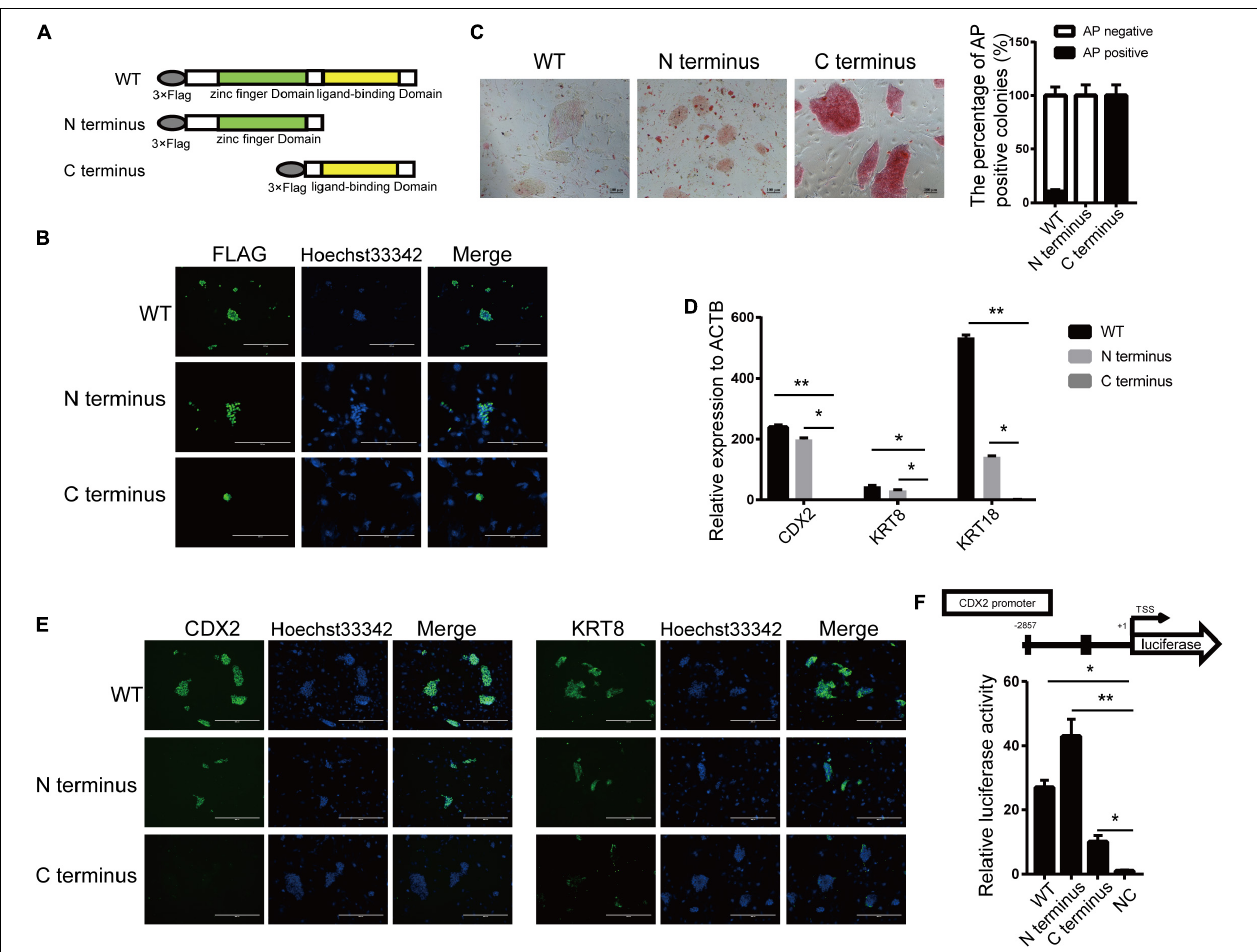
FIGURE 4 | N-terminal of ESRRB was the main domain in regulating CDX2. (A) A schematic illustration of the different domains of ESRRB with a FLAG epitope. (B) Immunofluorescence analysis of FLAG in the three constructed cell lines. (C) Representative image of AP-stained colonies after 5 days of clonal growth of the three constructed cell lines. The scale bar represents 100 µ m. The quantitative analysis of AP-positive rate is shown by histogram. (D) qRT-PCR analysis of the CDX2, KRT8, and KRT18 expressions in the three constructed piPSC lines. * p < 0.05 and ** p < 0.001. (E) Immunofluorescence analysis of CDX2 and KRT8 in the three constructed cell lines. The scale bar represents 200 µ m. (F) Promoter-luciferase assays for the CDX2-binding region of ESRRB-WT, N-terminus, and C-terminus. NC, empty vector. Data are from three biological replicates and are shown as mean ± SEM.